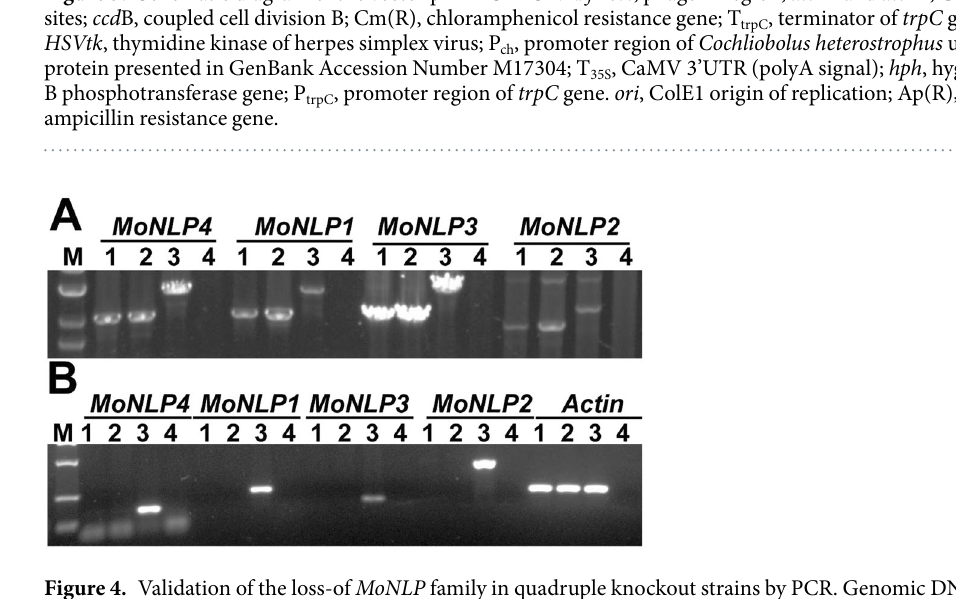
Figure 4. Validation of the loss-of MoNLP family in quadruple knockout strains by PCR. Genomic DNA of MoNLP knocked-out strains was amplified with specific primers annealing at sequences flanking the target regions subjected to homologous recombination ( A ) and with primers annealing at MoNLP coding regions ( B ). M indicates the molecular marker. Two independent knockout strains (1, 2), wild type M. oryzae (3), and water control (4) were